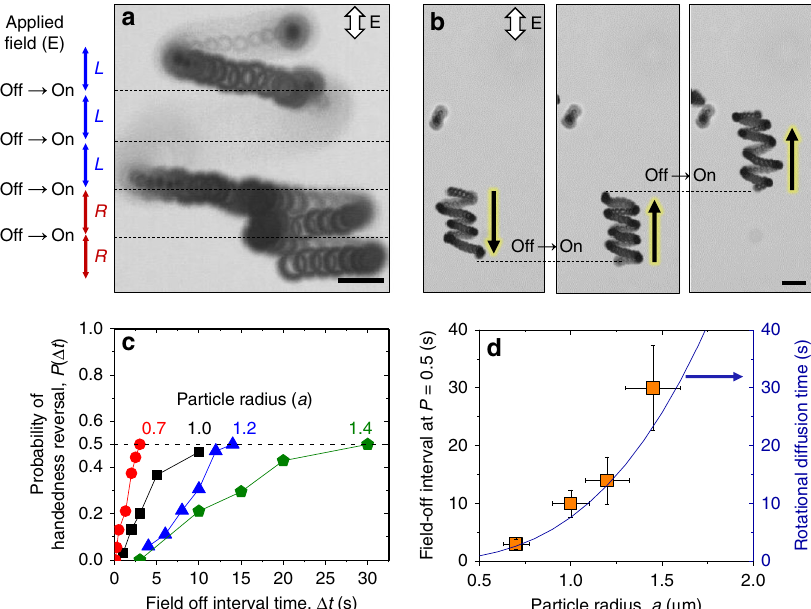
Fig. 3 Dynamic switching of handedness and direction of propulsion. a , b Microscope images showing reversals of handedness and direction of helical trajectories when cycling the electric fi eld on and off for particles of radius 1.2 µ m and φ = 5°. The applied fi eld strength is 250 V cm − 1 at 10 kHz, and fi eld- off interval is 5 s for a and 10 s for b . The scale bars in a and b are 5 µ m. c Experimentally determined probability for reversing the handedness of helical trajectories as a function of the fi eld-off interval duration, Δ t . Along the dashed line, the particle is equally likely to adopt helical motions of either handedness. The numbers in the plot represent the particle radius (in µ m) used in determining the probabilities P ( Δ t ) of corresponding color. d Increase in characteristic fi eld-off interval for equiprobability of inverting helix chirality with increasing particle radius. Here, the points represent experimentally determined data and the solid line corresponds to the theoretically calculated diffusion time. The y -error bars in d refer to the standard deviation of probability values for multiple experiments and x -error bars refer to the polydispersity of the particle